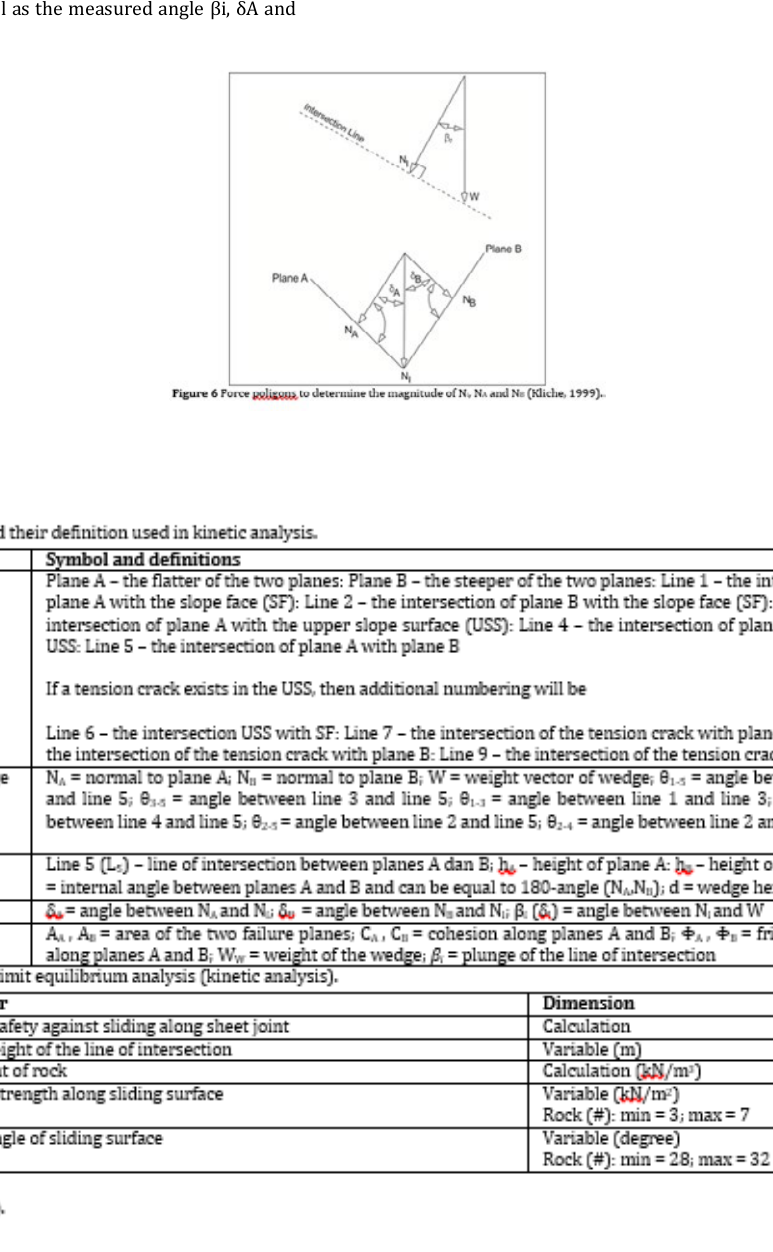
Location on the stereonet of wedge weight, W; the normal Ni, NA and NB and angle to the normal, βi (δi), δA and δB (Kliche, 1999). The resisting force on plane A and B according to Mohr-Coulomb criterion are as follows; CA + NAtan A CB + NBtan B